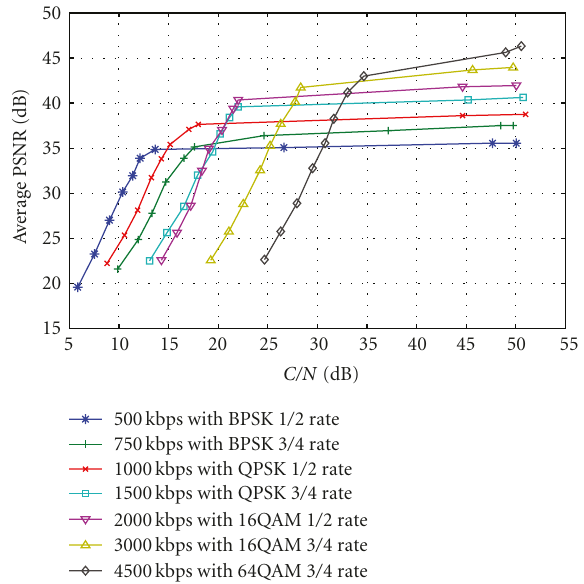
Figure 3: Video quality-based algorithm, foreman , NAL unit max size: 750